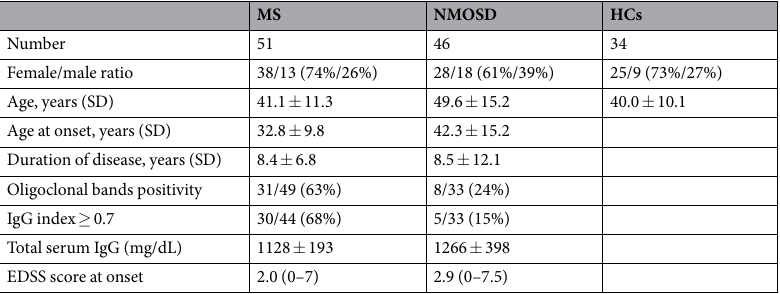
Table 1. Baseline characteristics of study population. MS, multiple sclerosis; NMOSD, neuromyelitis optica spectrum disorders; HCS, healthy controls; EDSS, Expanded Disability Status Scale.